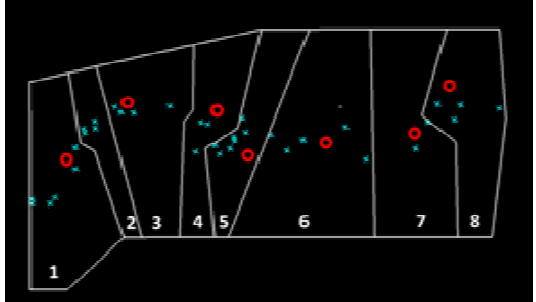
Figure 3. Segmented blocks (Block 1-8). Check dam locates in the left side of the figure. Circles show locations of surveying poles and x-marks are surveyed